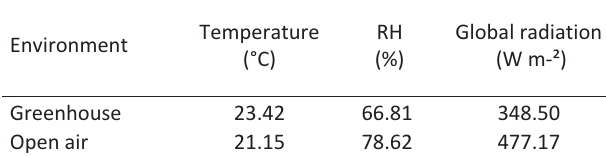
Table 2 ­ Environmental conditions: temperature (T°C), relative humidity (RH%) and global radiation (W m­²) in the two cultivation environments (in open­air benches and greenhouse benches) during the cultivation period of peach trees cv. Capdeboscq